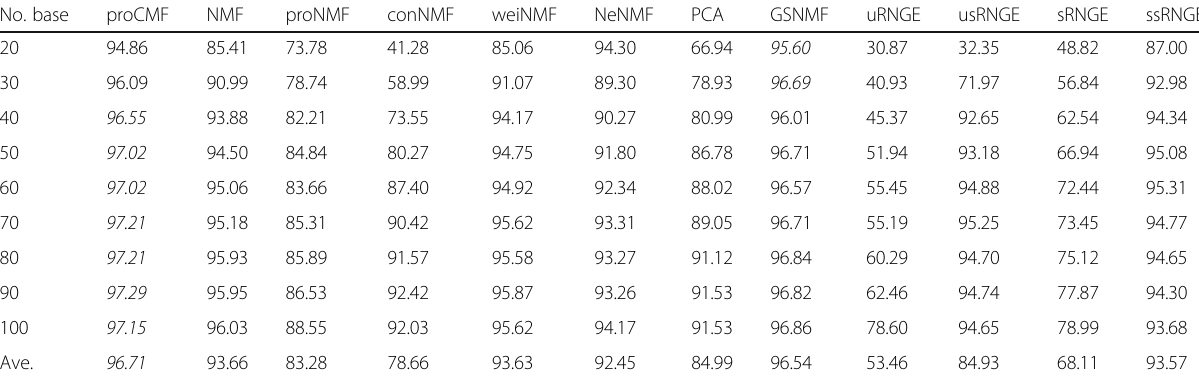
Table 1 Facial expression recognition rate (%) using the CK+ dataset with different subspace dimensionalities (case 1: no. training = 1) No. base